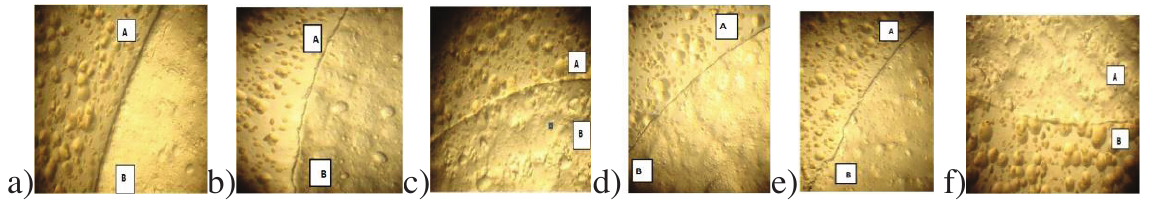
Figure 11: The sensitivity test of leather surfaces against Escherichia coli ATCC 25922 (a,b, c) and Staphylococcus aureus ATCC 25923 (d,e,f). B areas are leather surfaces (a, b, d and e samples are treated and c and f are untreated samples) and A areas are medium outside leather surfaces.